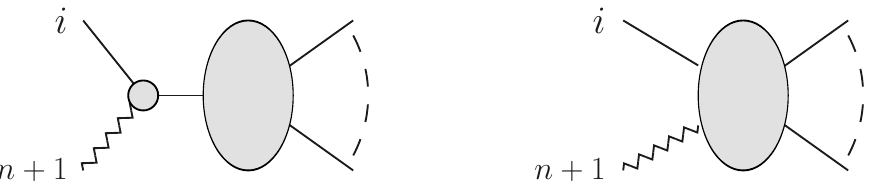
Figure 1 . The two types of contributions to a soft limit of an amplitude with n + 1 particles. The first has a pole when p n +1 0 while the second does not. The zig-zag line represents a → particle of spin j whose momentum is taken to be soft; straight lines represent particles of spin j i ( i = 1 , 2 , . . . , n